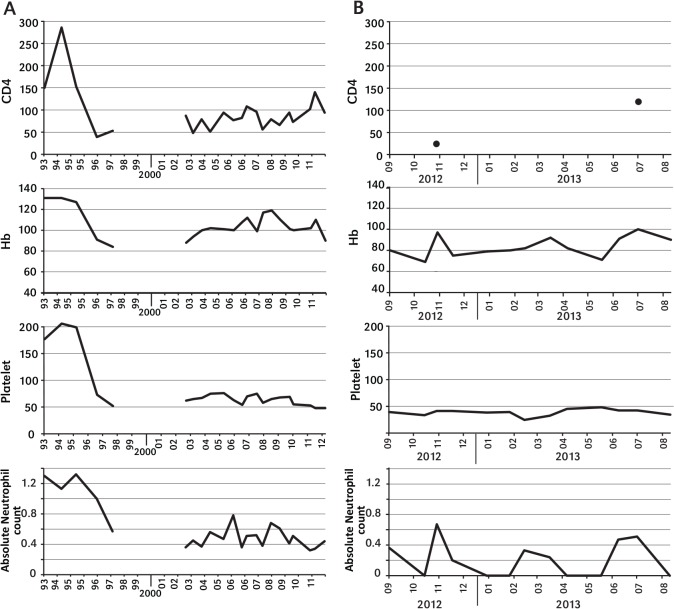
(A) Trend of CD4 count, haemoglobin, platelet count and absolute neutrophil count, prior to treatment with liposomal daunorubicin 1993–2012.(B) Trend of CD4 count, haemoglobin, platelet count and absolute neutrophil count, September 2012-August 2013.